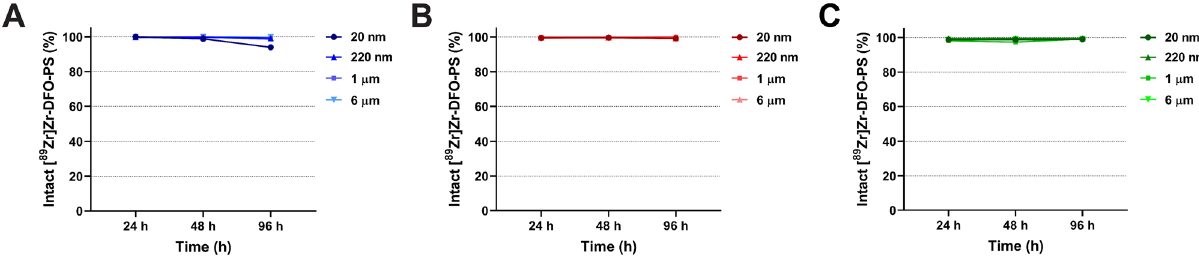
Figure 2. In vitro stability of [ 89 Zr]Zr-DFO-PS particles in ( A ) phosphate buffered saline (PBS, pH 7.4), ( B ) simulated gastric fluid (SGF, pH 3.0), and ( C ) simulated intestinal fluid (SIF, pH 6.0). All experiments were performed in triplicate. The values are presented as mean ± standard